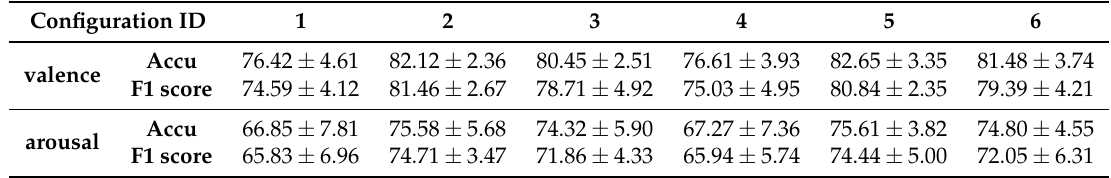
Table 6. The performances of different configurations of LSTM for valence and arousal. The average accuracies (Accu%) and F1 score (%) are subject to 10-fold cross validation.